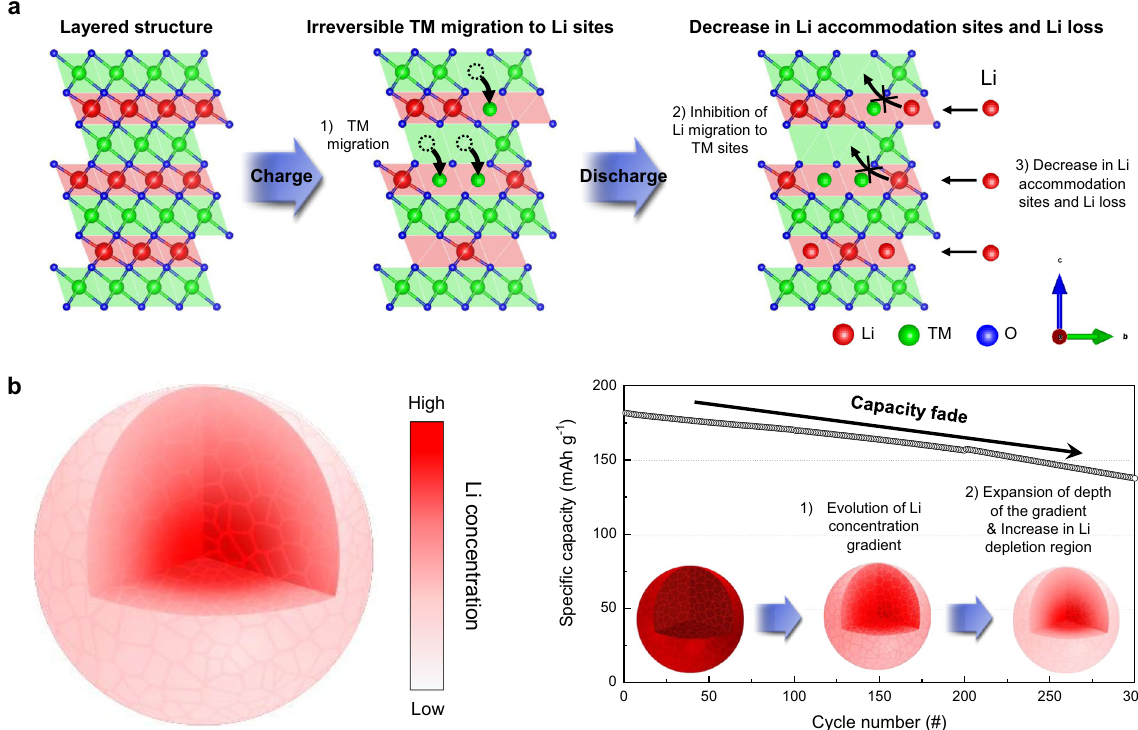
Fig. 5 Comparison of Li distribution with the increasing number of cycles. a Schematic illustration of Li accommodation sites during the charge – discharge process. TMs occupy 3b Li sites in the Li layer during the charging process. This irreversible TM migration depletes the number of Li accommodation sites in the Li layer. In contrast, Li ions simply re fi ll a few vacant 3b Li sites, avoiding the 3a TM sites during the discharge process. Thus, a local Li de fi ciency originates from the lack of Li accommodation sites, depleted by the irreversible TM migration. b Schematic illustrations of the Li distribution evolution with the increasing number of cycles. The Li concentration gradient along the radial direction, which is lower at the surface and higher in the central area, evolves during cycling. The depth of the gradient and the extent of Li depletion both increase with the increasing number of cycles owing to the lack of Li accommodation